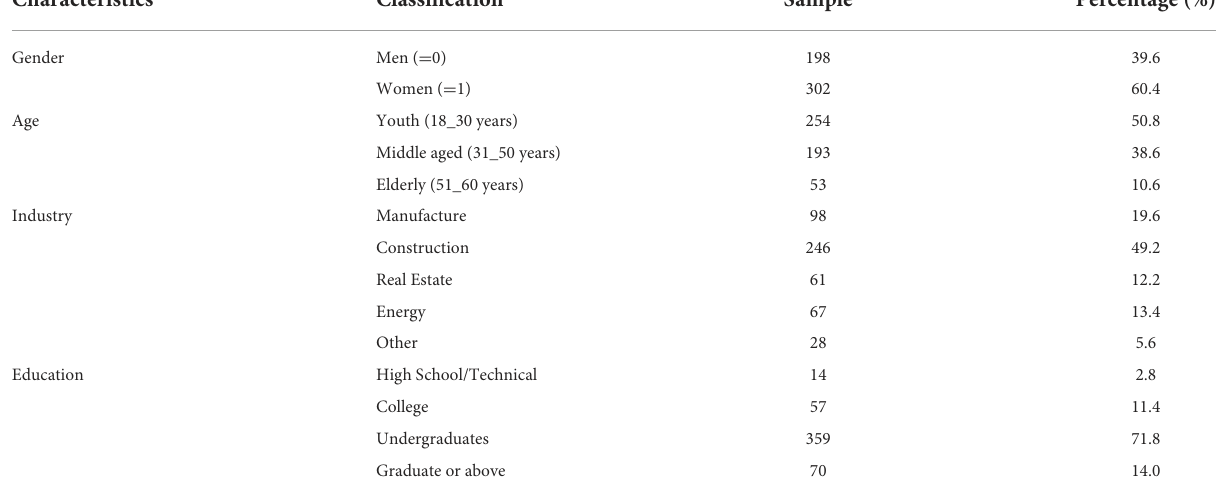
TABLE 2 Sample characteristics ( N = 500).